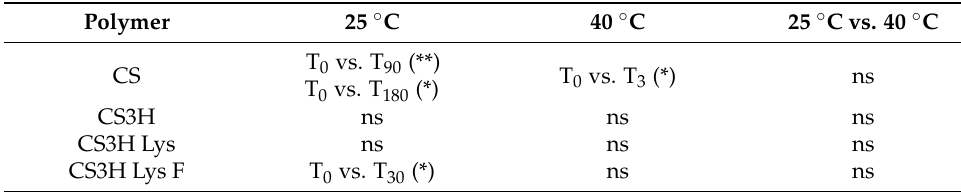
Table 4. Results of the statistical evaluation of absorbance values at 639 nm of different mouthwash formulations over time and at different temperatures. Two-way ANOVA was performed, followed by Sidak’s multiple comparisons test to see the effect of the temperature on the absorbance of the dye in the mouthwash formulation. The data were rerun with Dunnett’s multiple comparisons test to see the effect of the time (ns = not significant or p > 0.05; * p ≤ 0.05; ** p ≤ 0.01).